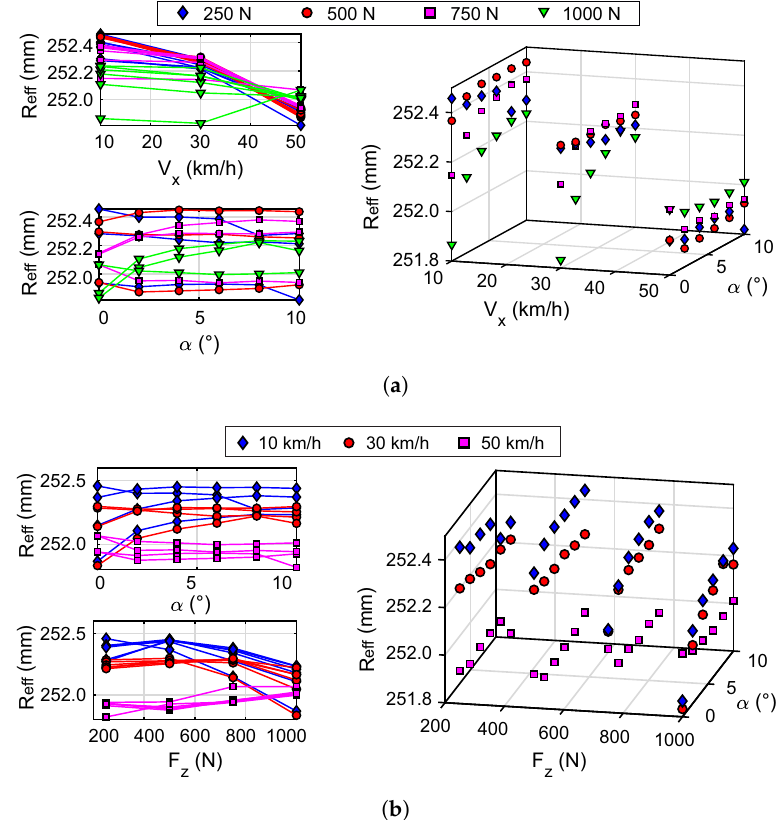
Figure 12. Effective radius results obtained by applying the proposed methodology to the experimental data. ( a ) Data differentiated by vertical load; ( b ) Data differentiated by rolling